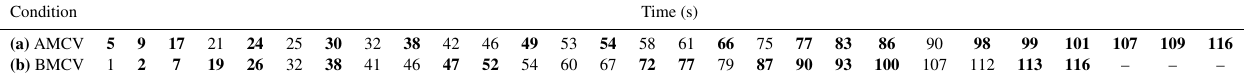
Figure 9. Wavelet power spectra (Morlet wavelet) for above the measured mean critical velocity experiment ( u > u cr,measured ) for a 2min period showing the (a) momentum flux ( u (cid:48) ,w (cid:48) ), (b) sediment flux ( c (cid:48) ,w (cid:48) ), and (c) coherence between the momentum and sediment fluxes. Table 2. Major ejection (bold values) and sweep events in the presented (a) AMCV and (b) BMCV time series. Condition Time